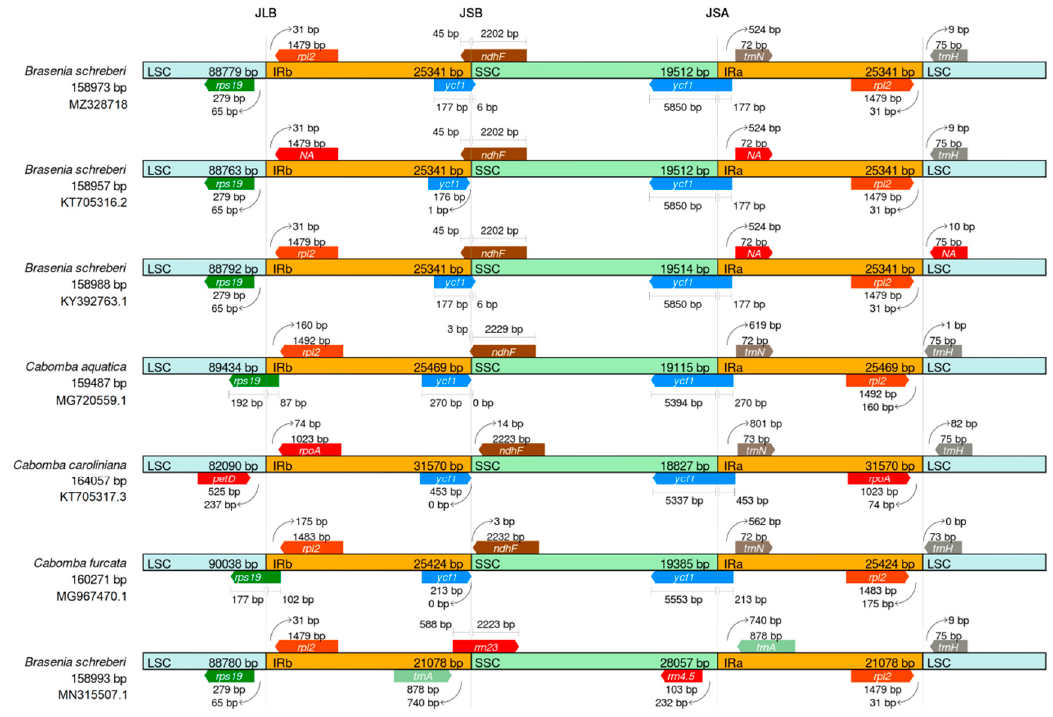
Figure 6. Boundary analysis of LSC, SSC, IRa-IRb regions of chloroplast genomes of seven species of Cabombaceae. Full lines between each colored boxes represent the point of junction. Four colors represent four areas in cpDNA genome. Numbers represent the length of each gene and the distance between the ends of genes and the border